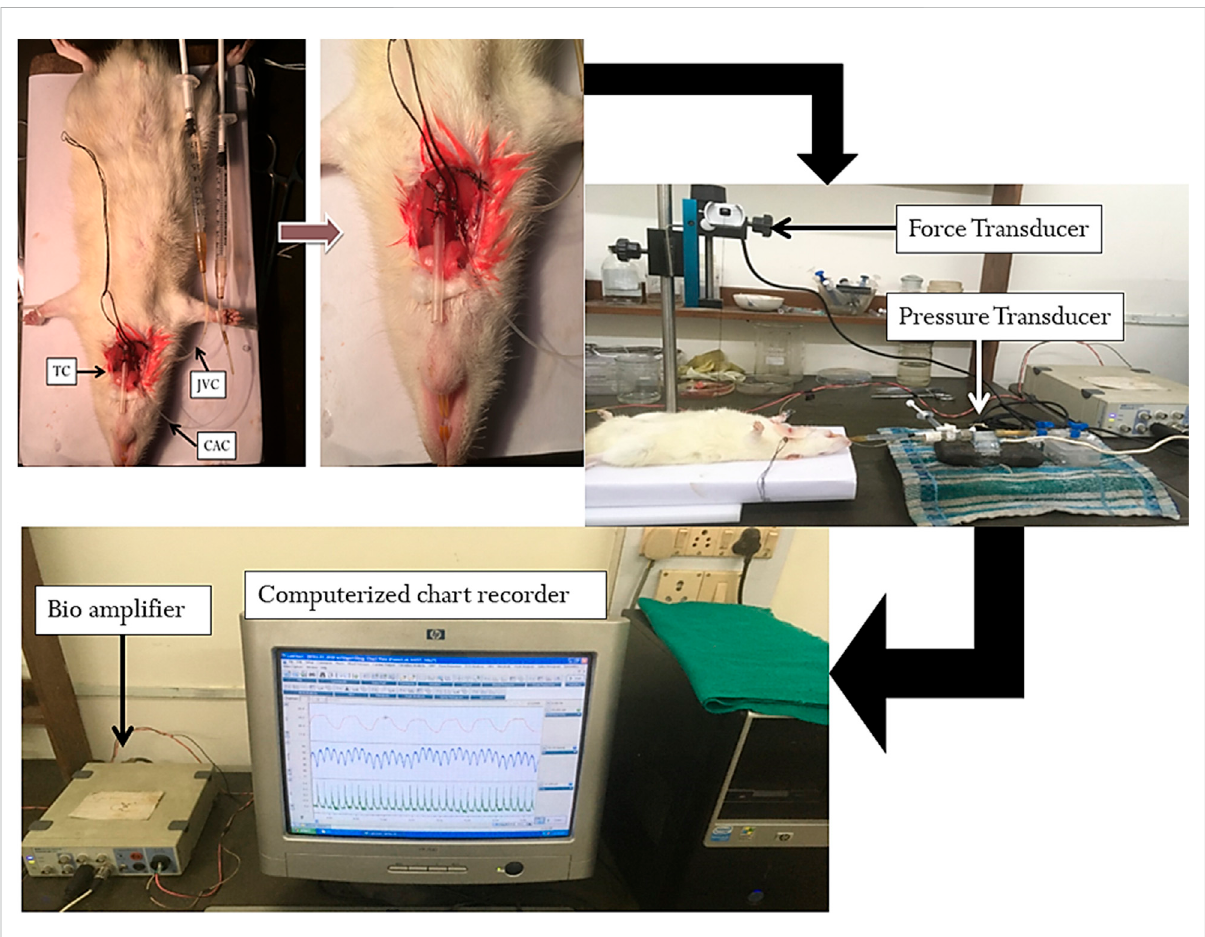
FIGURE 2 Experimental procedure and setup stating cannulation and recording of biophysical parameters. Experimental procedure and setup that outlines cannulation and recording of biophysical